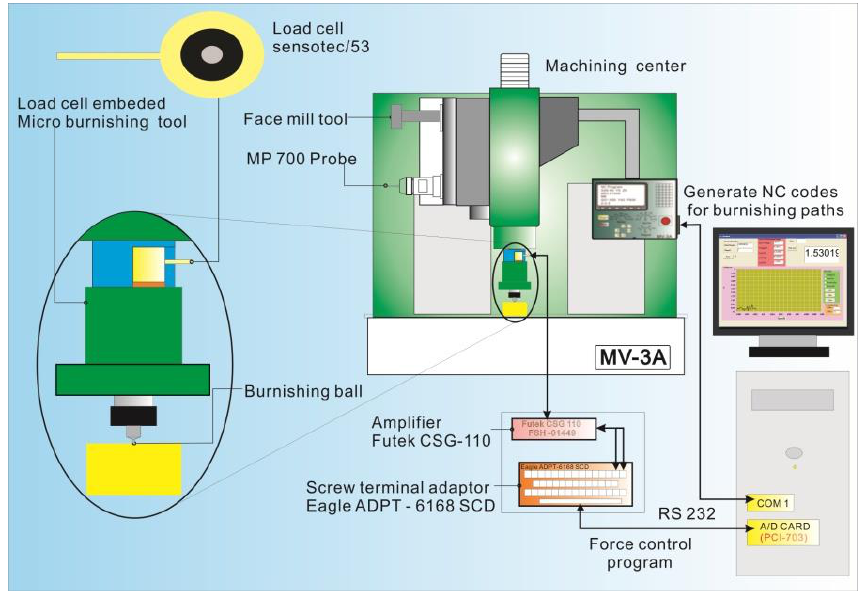
Figure 10. Experimental setup of the ball-burnishing process.